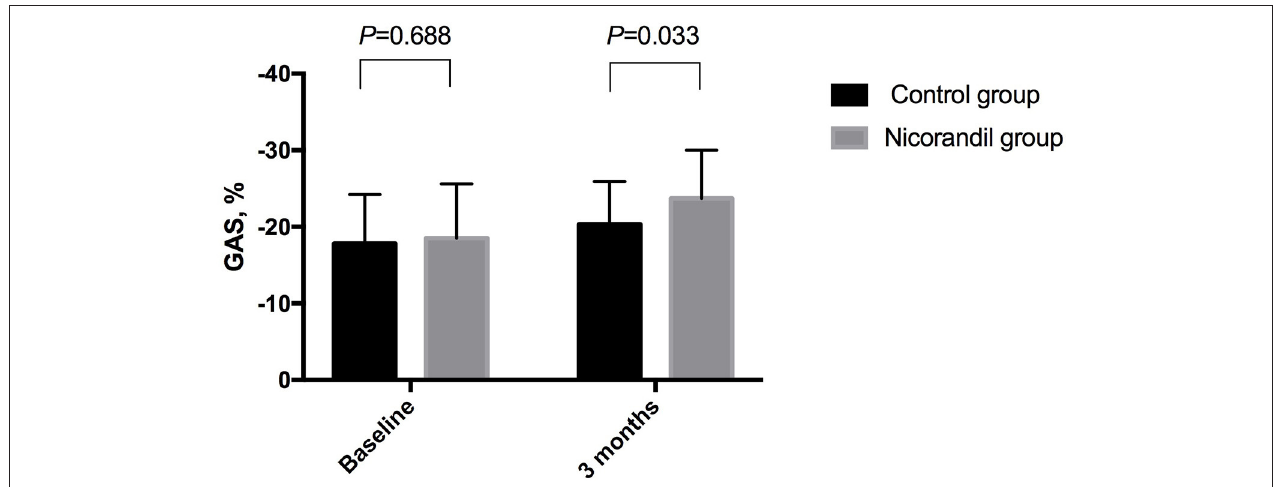
FIGURE 2 | Comparison of GAS between the nicorandil group and the control group. GAS, global area strain.